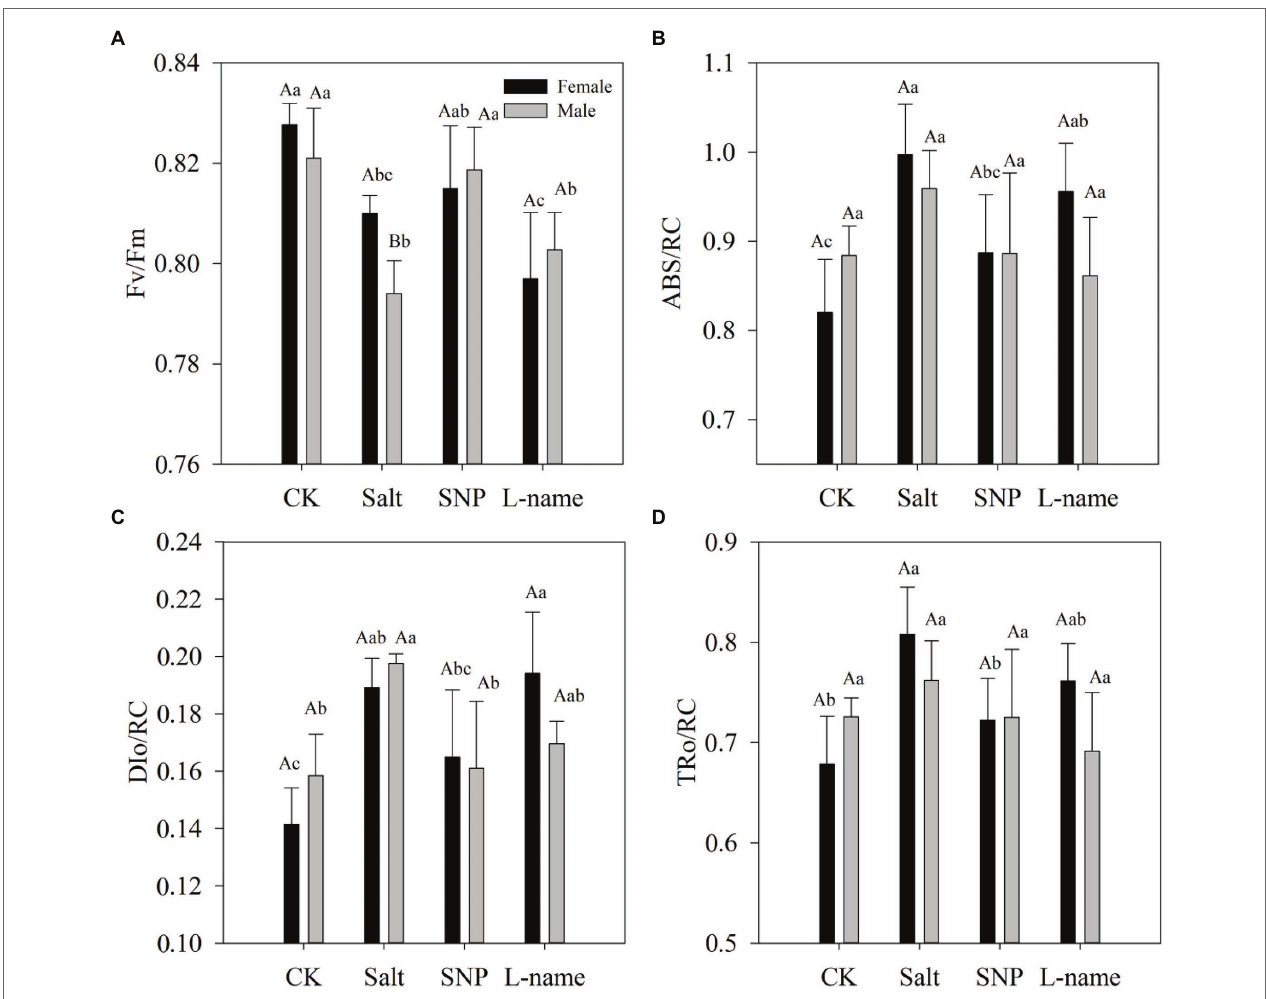
FIGURE 2 | Chlorophyll fluorescence parameters (Fv/Fm: A ; ABS/RC: B , DIo/RC: C , TRo/RC: D ) measured in T. grandis in response to different treatments. CK (control, distilled water), salt (100 mM NaCl), SNP (100 mM NaCl with 0.05 mM SNP), and L-name (100 mM NaCl with 0.5 mM SNP and L-name). Different uppercase letters indicate a significant difference between different genders at p < 0.05, and different lowercase letters indicate significant difference under salt treatment at p < 0.05, according to Duncan’s